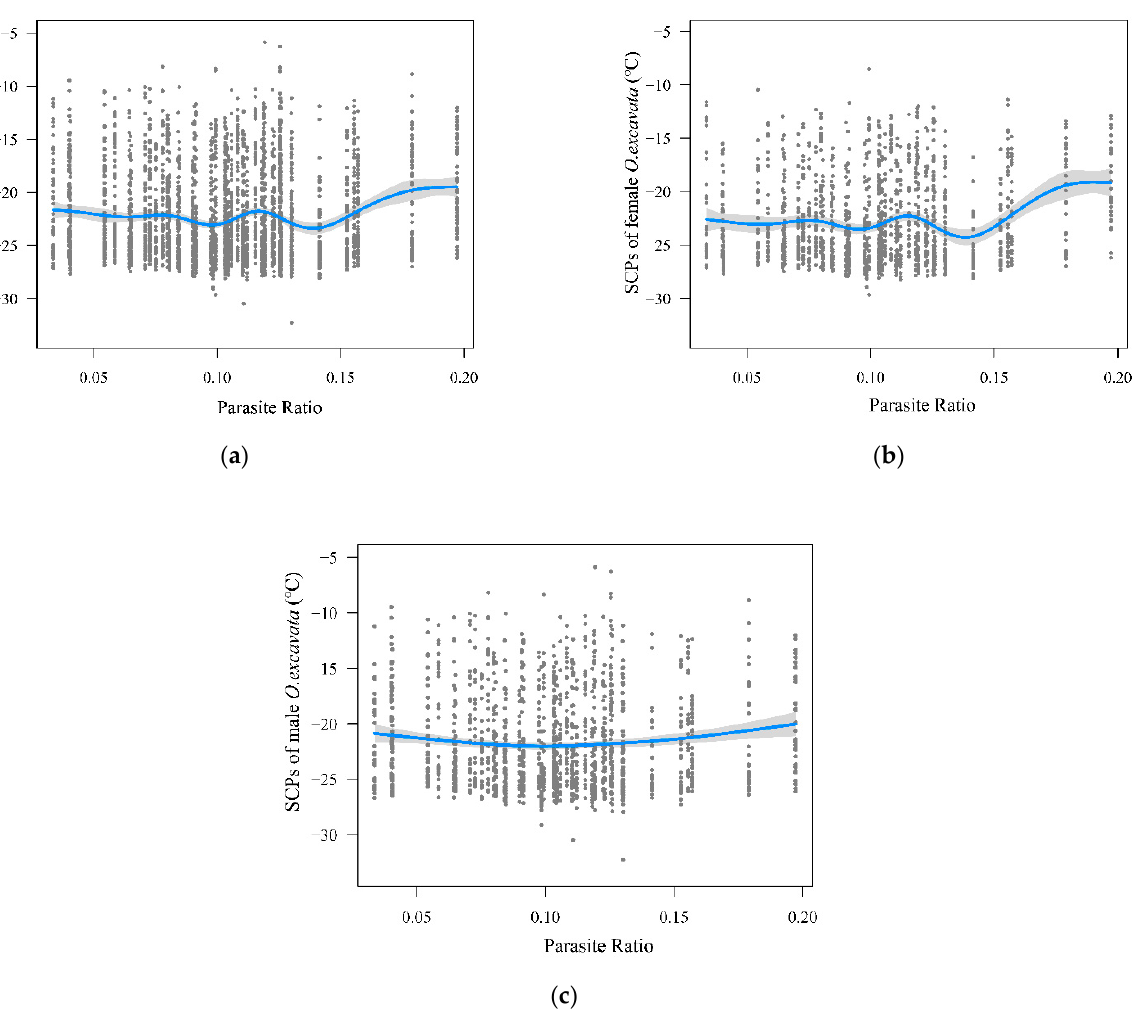
Figure 4. Influence of parasite ratio on SCPs of O. excavata in ( a ) general, ( b ) females, and ( c ) males. Points show the raw data. Blue lines represent the result of the generalized additive model. The shaded areas represent the 95% confidence interval.